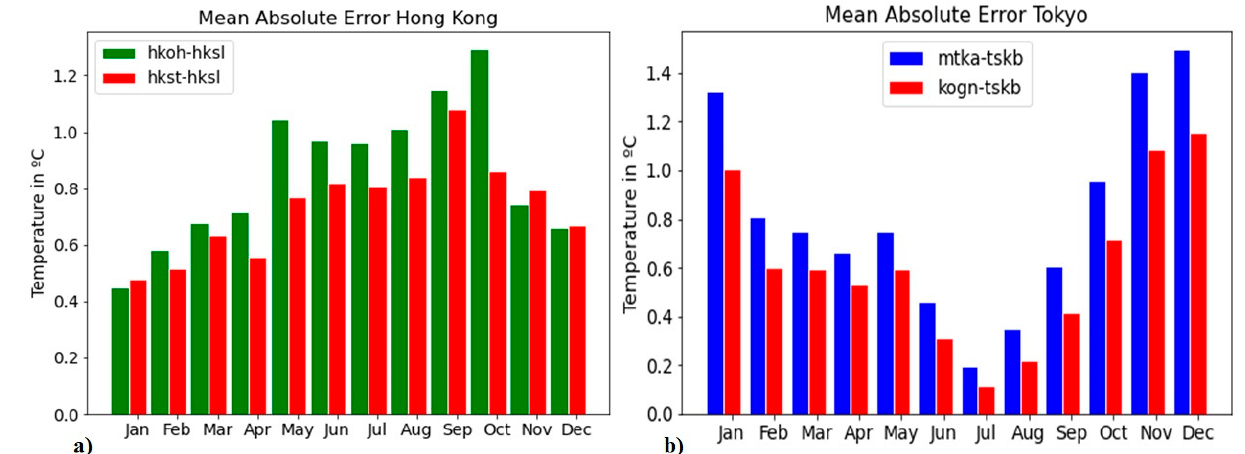
Figure 6. ( a ) Mean absolute error for data in Hong Kong. ( b ) Mean absolute error for data in Tokyo